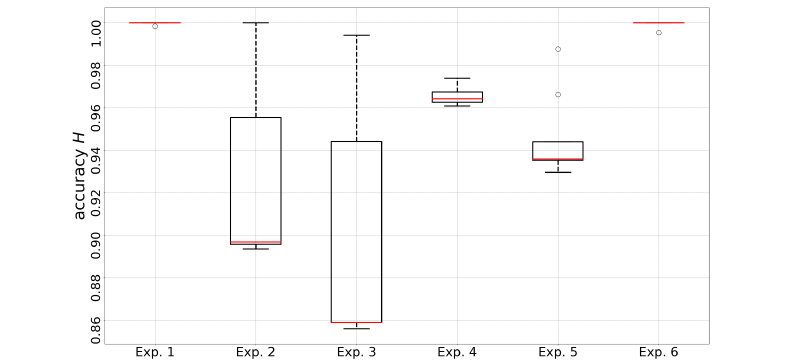
Figure 11. The distributions of accuracy rate H of the multi-compound discrimination models in each trial. The discrimination models are periodically updated ( T UD = 30 s) during the exposure state, which may result in different